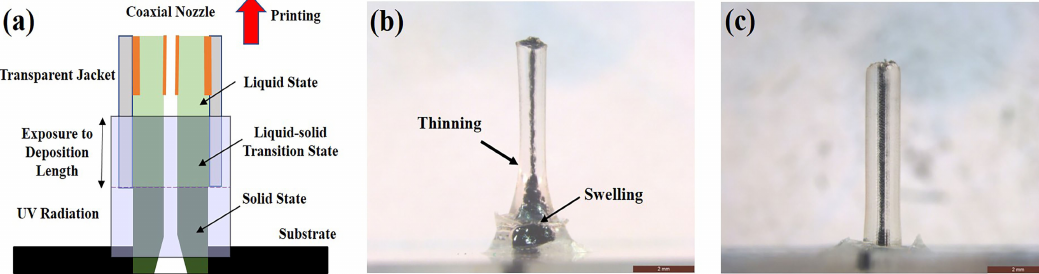
Figure 7. ( a ) Schematic of material conversion mechanism in printing. Typical printing results in pre-cure time investigation: ( b ) hollow structure with thinning and swelling when pre-cure time at 4 s; and ( c ) uniform-shaped hollow structure with a well constrained inner channel when pre-cure time at 6